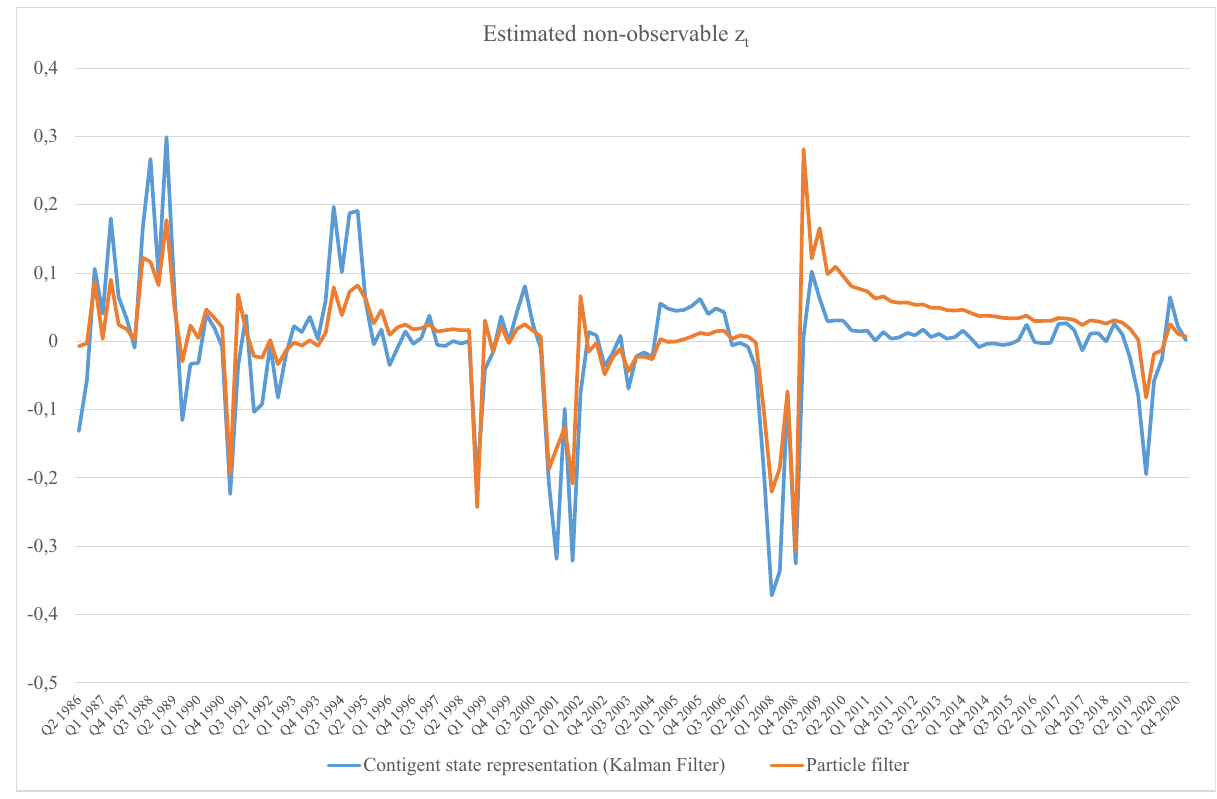
Figure 3: Deviation estimated of the current in fl ation target from its long - term